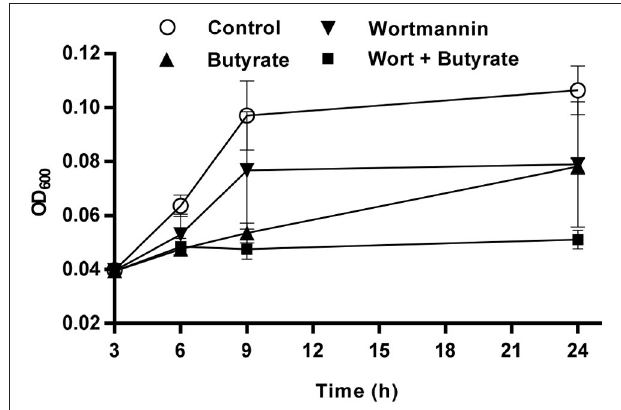
FIGURE 9 | Augmentation of the antibacterial activity of chicken monocytes by wortmannin and butyrate. Chicken monocytes were stimulated with 40 µ M wortmannin, 4mM butyrate or their combination for 24h. Cell lysates were then incubated with Salmonella enteritidis (ATCC 13076) at 37 ◦ C. The bacterial turbidity was measured at OD 600 at 3, 6, 9, and 24h. The results are means ± SEM of two independent experiments.